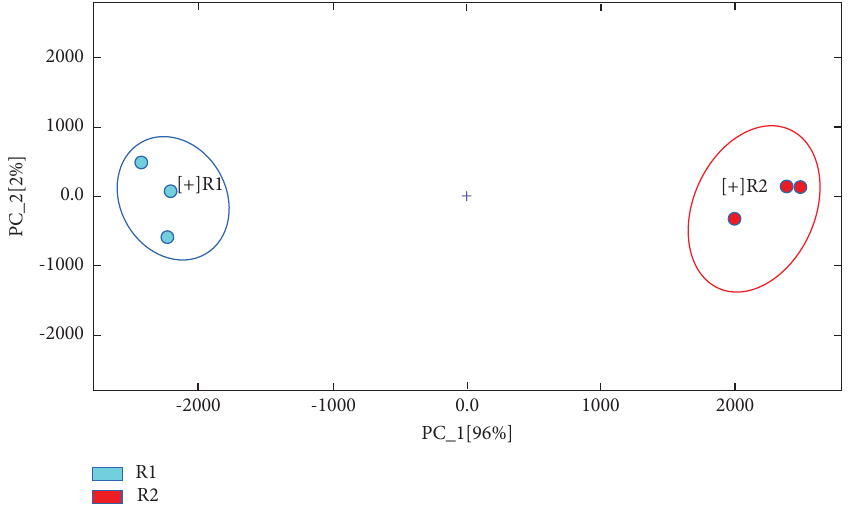
Figure 4: Principal component analysis for royal jelly samples at − 20 ° C and 28 ° C based on the volatile compounds’